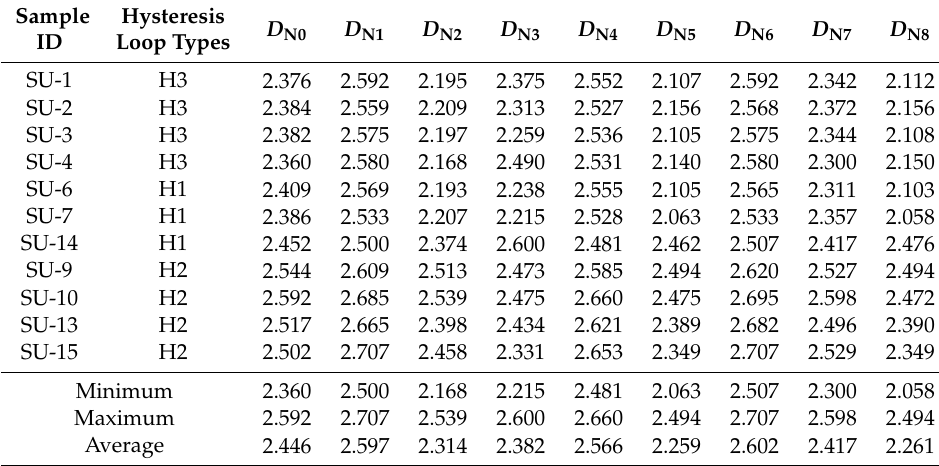
Fractal dimensions from N 2 adsorption data of di ff erent class He 8 Member tight sandstone samples.